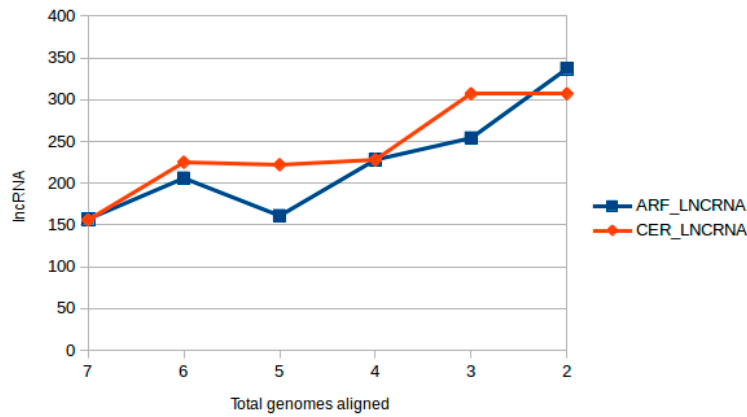
Figure 2. lncRNA interspecies conservation and genome alignment analysis: the graph shows the total number of genomes versus the total number of transcripts aligned to Fabaceae genomes ( Vicia faba , Glycine max , Medicago truncatula , Phaseolus vulgaris , Lotus japonica , Vigna unguiculata and Cicer reticulatum ). The blue line represents the lncRNA gathered from the ARF samples and the red line represents the lncRNA gathered from the CER sample, their alignment profile is very similar as expected, around 1800 transcripts aligned to at least one of the genomes used.